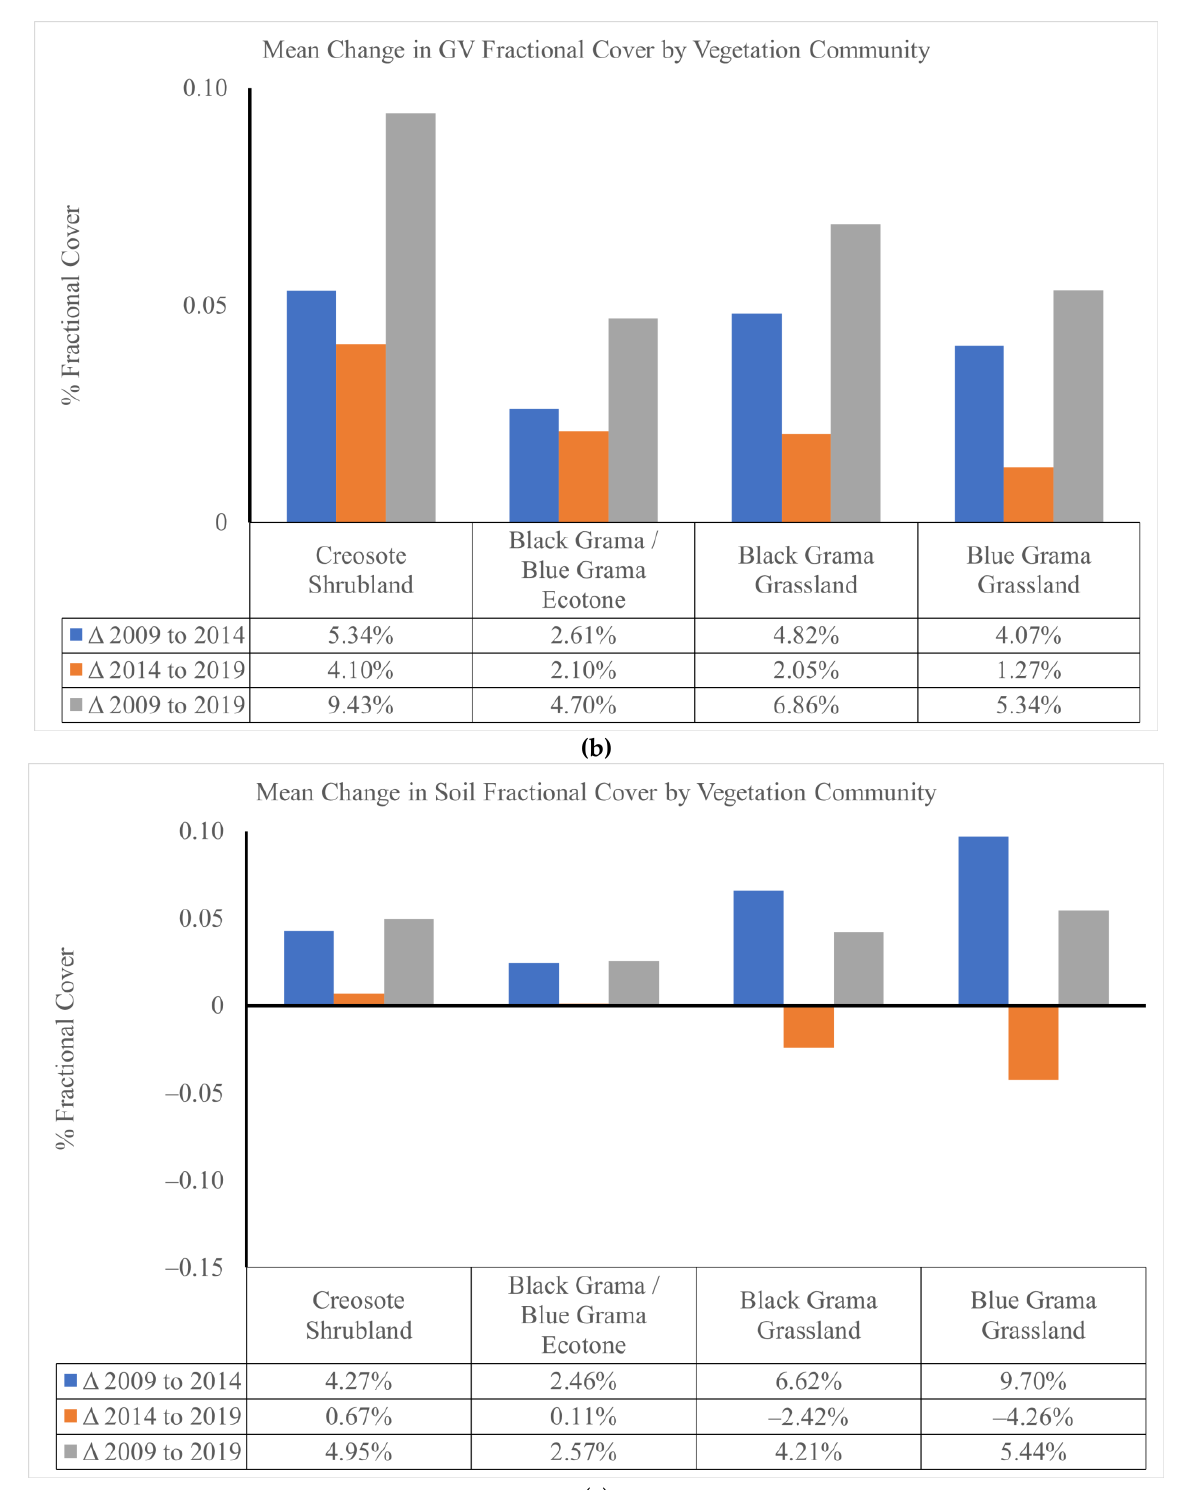
Figure 5. Graph of fractional cover changes detected by cover class within three grassland biomes (black grama, blue grama, and the ecotone between the two) and creosote shrubland. Community boundaries were derived from a classification map produced by the Sevilleta LTER in 1998. The results are divided into three time intervals: ( a ) 2009–2010 (drought + recovery period); ( b ) 2009–2014 (drought period); ( c ) 2014–2019 (recovery period).